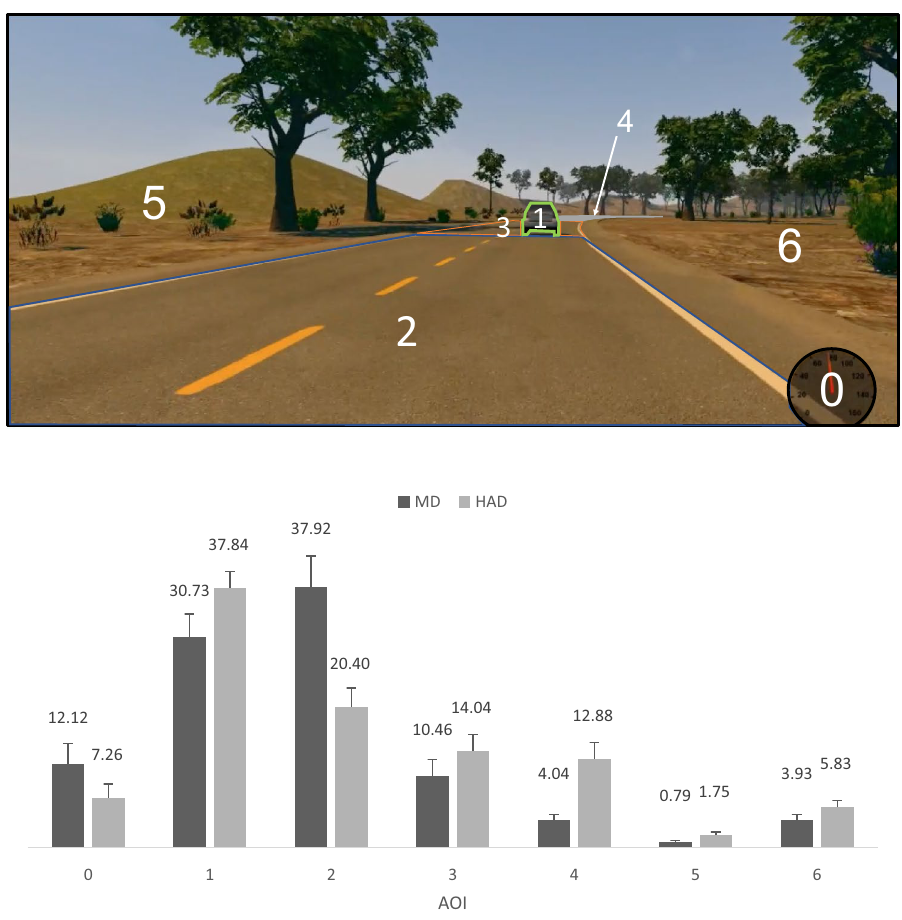
Figure 1. Top. Representation of the seven AOIs used for gaze position analyses. Note that the width of the background image was cropped (Photograph JN). Bottom. Relative frequency (in percentage) of AOI visits under Manual Driving (MD) and Highly Automated Driving (HAD). Error bars represent one standard